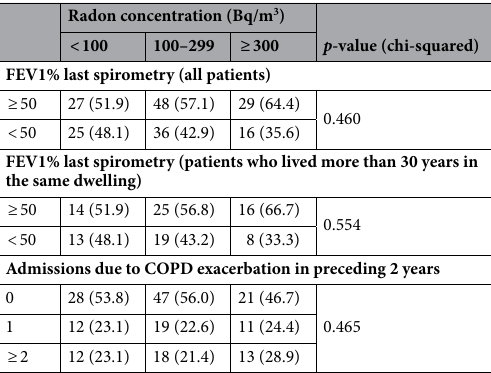
Radon concentration (Bq/m 3